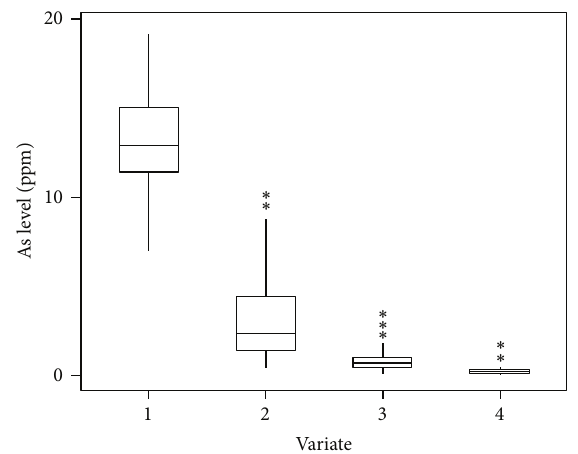
Figure 4: Outliers’ in the variate: 1, soil As, 2, straw As, 3, husk As, and 4, grain As which is denoted by ( ∗ ).